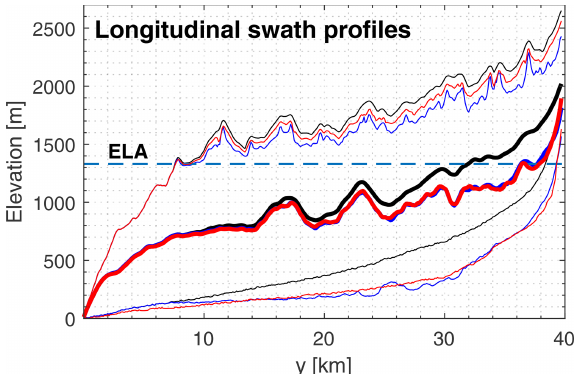
Figure 10. Topographic evolution of an initially fluvial landscape subject to glacial erosion. Maximum, mean and minimum eleva- tions of longitudinal swath profiles of the initial (black) and final landscapes in the iSOSIA and OpenLEM experiment are shown as blue and red lines,